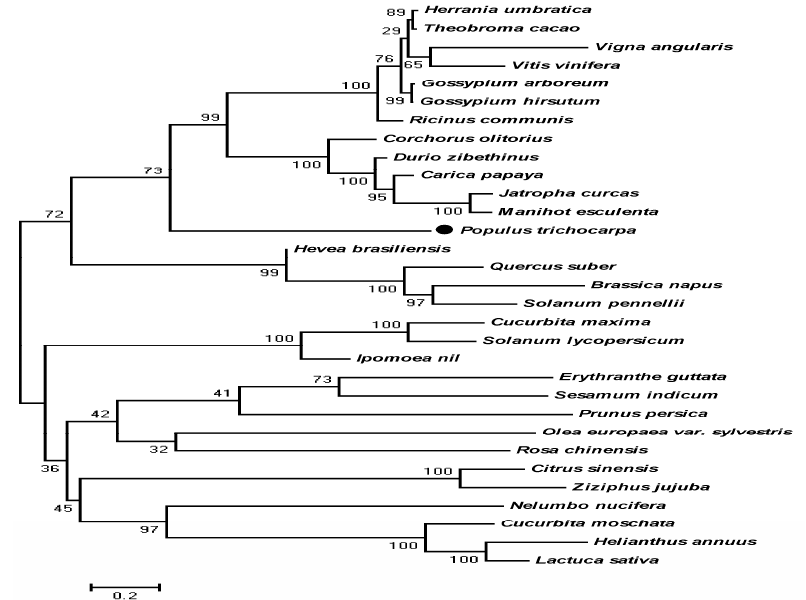
Figure 3. Phylogenetic tree showing the relationships between the Pt4CL-like (XP_002307770.2) amino acid sequence and other identified 4CL-like sequences. The tree was constructed using the neighbor-joining (NJ) method in MEGA 5.1 and bootstrapped 1000 times. Bootstrap percentages are indicated at the branch points. In all cases, tree topologies obtained using the NJ, minimum evolution, and maximum parsimony methods were identical. Accession numbers of Def sequences obtained from GenBank are as follows: Brassica napus (XP_013727429.1), Carica papaya